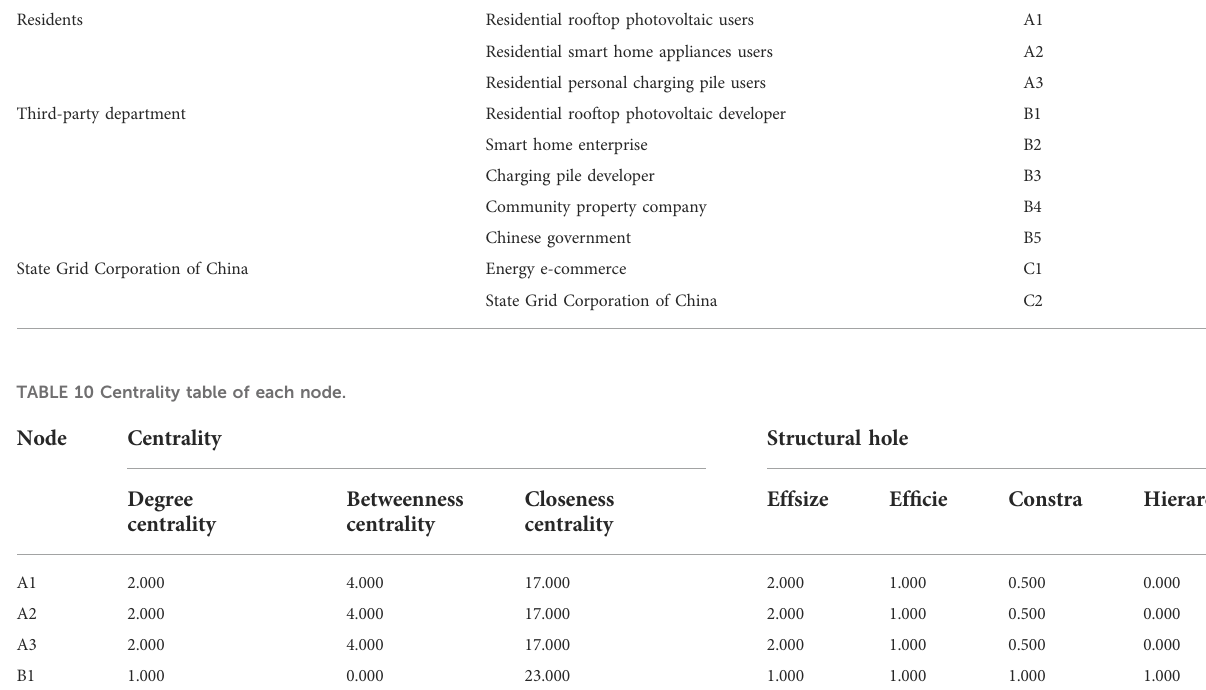
TABLE 9 Meaning of the representative letters of each node in the